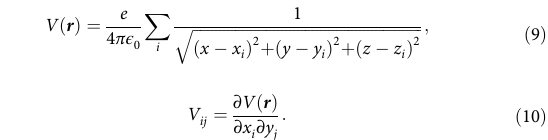
Fig. S2; right panel) do not show pronounced shoulder, expected for an I = 2 quadrupolar powder pattern in absence of m − 2 → − 1 and m 1 → 2 transitions. In